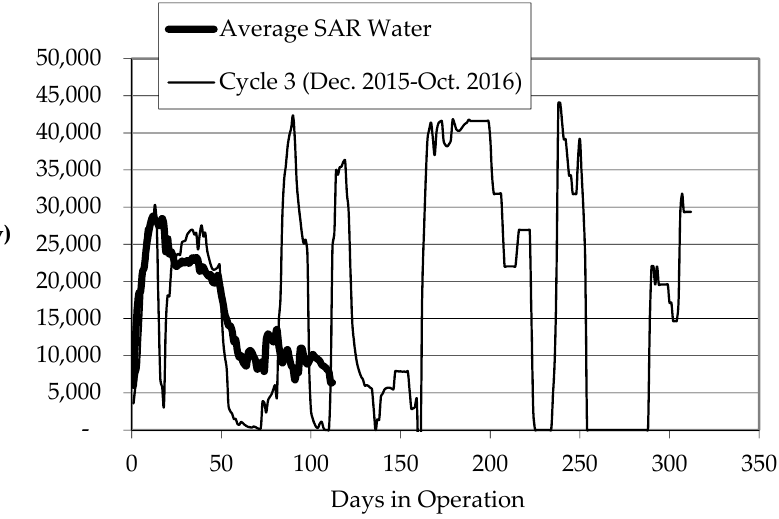
Figure 4. Olive Basin Percolation Rate with Water from Unfiltered Santa Ana River (SAR) and Riverbed Filtration System.